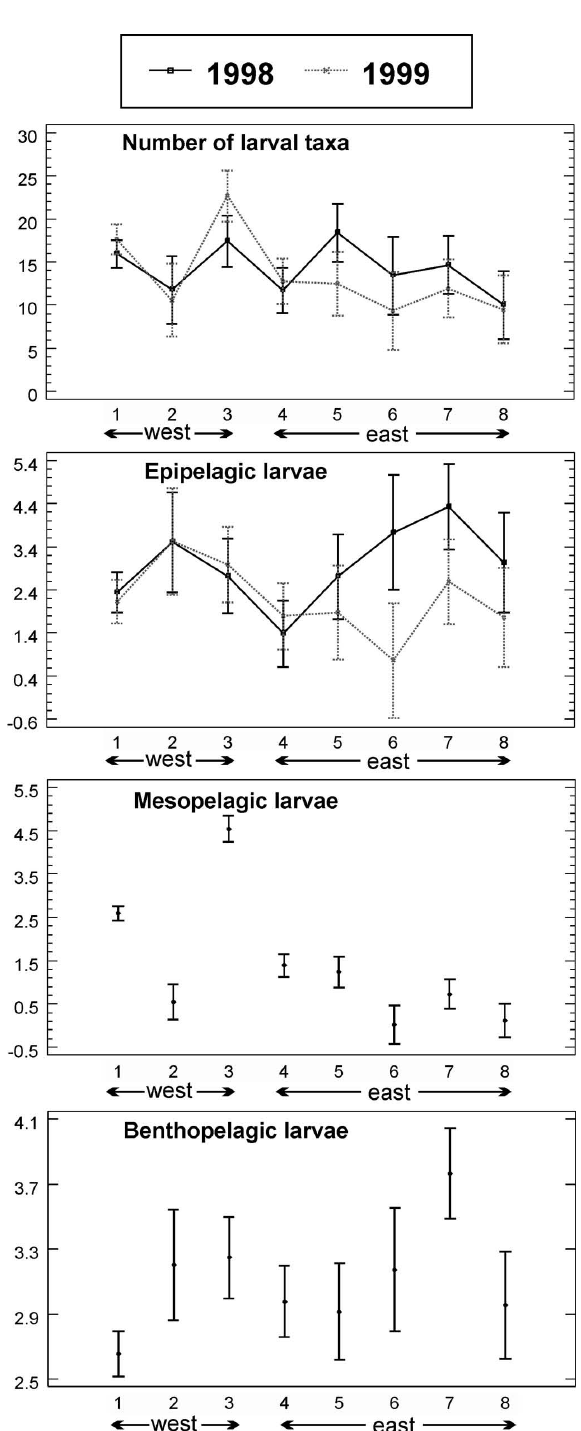
Fig . 4. – Mean values and 95% Bonferroni-corrected confidence intervals per sub-region and survey for the number of larval taxa as well as for the log (x+1)-transformed larval abundance (ind m -2 ) of different fish types (epipelagic, mesopelagic, benthopelagic species). 1, Ionian Sea; 2, Patraikos Gulf; 3, Korinthiakos Gulf; 4, Saronikos Gulf; 5, Aegean Sea; 6, S. Evoikos Gulf; 7, N. Evoikos Gulf; 8, Pagasitikos Gulf. The effect of year and the year*sub- region interaction was not significant (P>0.05) for mesopelagic and benthopelagic